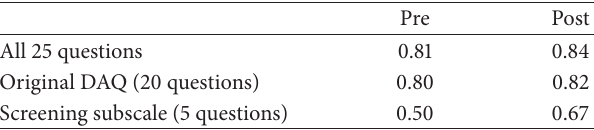
Table 2: Cronbach’s alpha for the DAQ and five added questions. Table 3: Screening items.